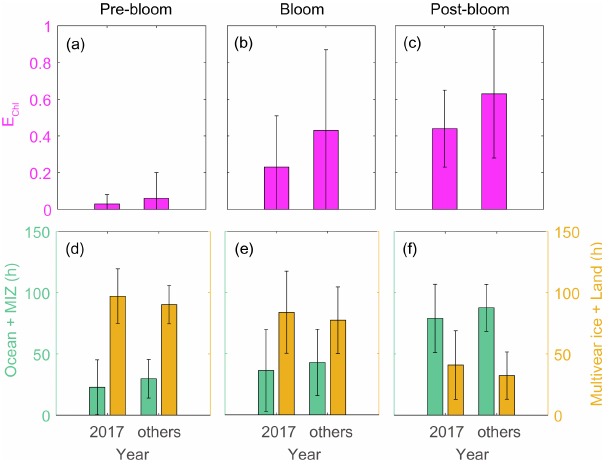
Figure 10. R Bio (a–c) and the black carbon (BC) and total SO 2 − concentrations (d–f) during pre-bloom, bloom, and post-bloom pe- riods. Error bars represent 1 σ .